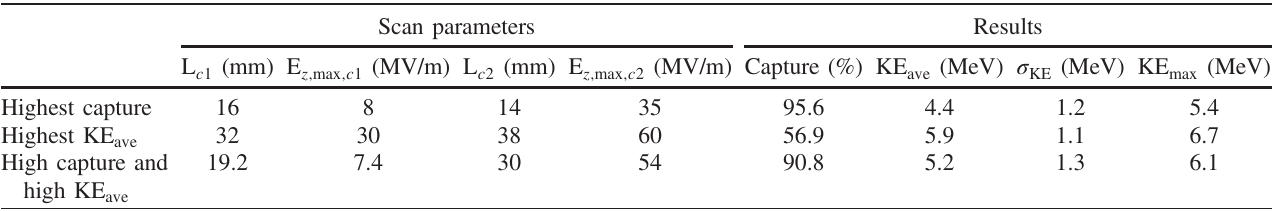
TABLE II. Selected representative 1D scan results.